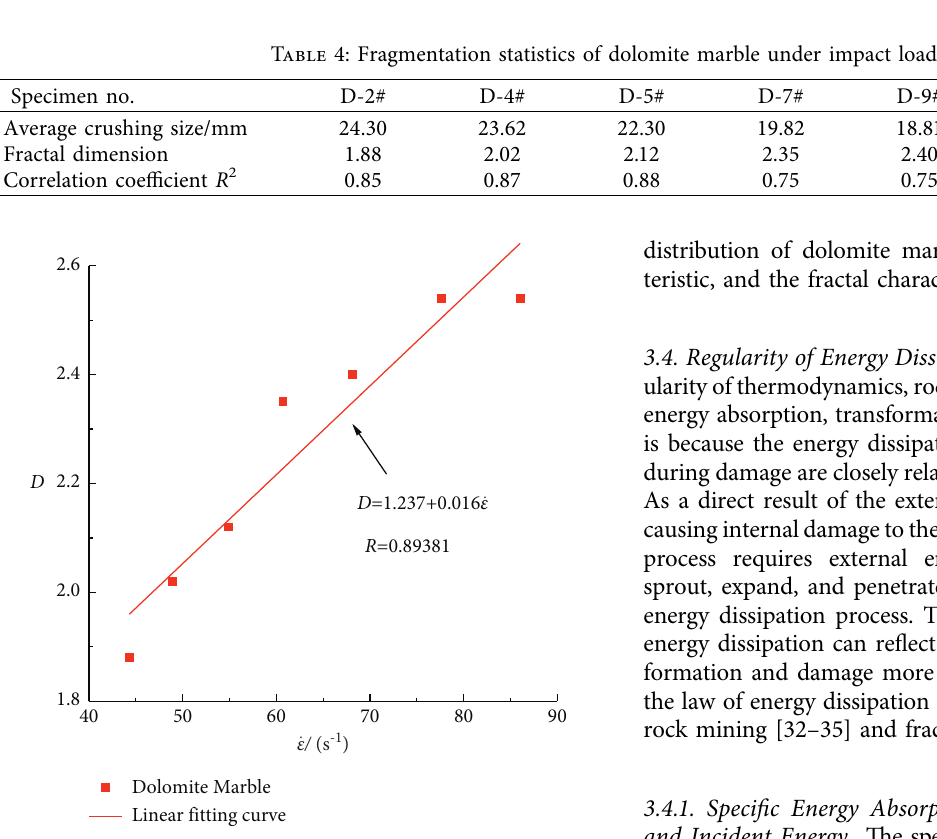
Figure 8: Relationship between the fractal dimension and the strain rate.